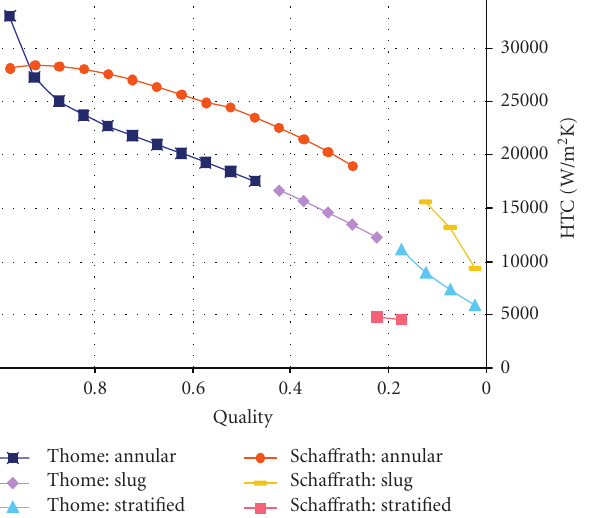
Figure 15: Comparison between Thome’s analysis and Scha ff rath’s analysis with dominant annular flow (G = 417.6 kg/sm 2 ).